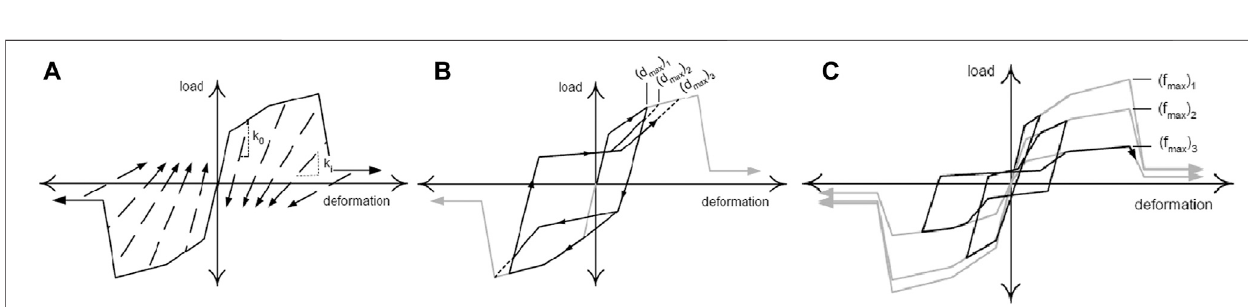
FIGURE 9 | “ Pinching4 ” material model (adapted from Lowes et al. (Kim and LaFave, 2012)).